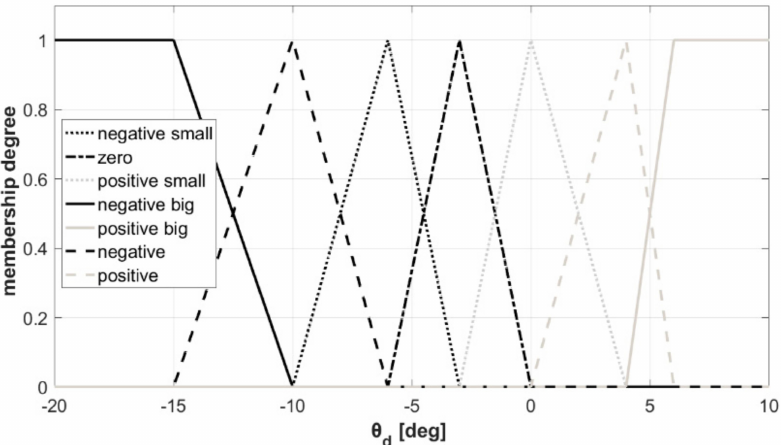
Figure 11. Membership degree of the output variable desired pitch angle θ d associated with fuzzy sets: positive big, positive, positive small, zero, negative small, negative, negative